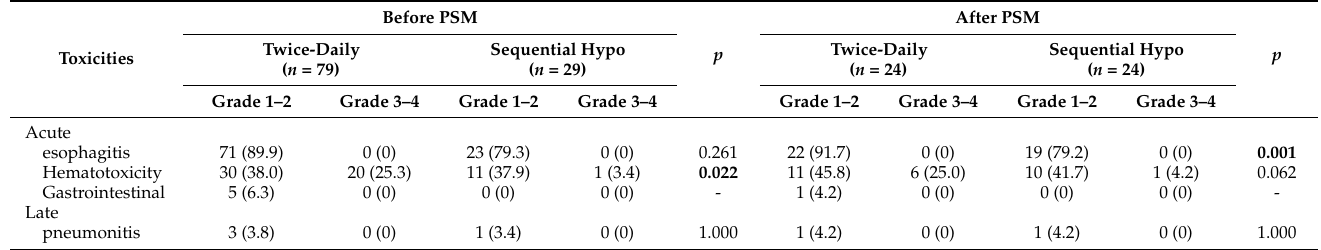
Table 5. Acute and late toxicities during treatment before and after PSM [ n